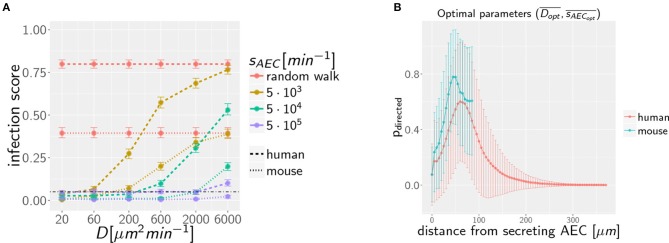
(A) Infection scores IS for random walk migration and selected examples of chemokine parameters in the limit of low fungal burden with AON = 1. Dashed-dotted black line indicates the threshold infection score at ISt = 5%. Error bars represent 95%-confidence intervals received from bootstrapping. (B) Mean probability for directed AM migration pdirected following the underlying chemokine gradient as a function of the distance from the source AEC. Chemokine parameters are set to the corresponding optima Dopt¯ and sAECopt¯ in mice and men.